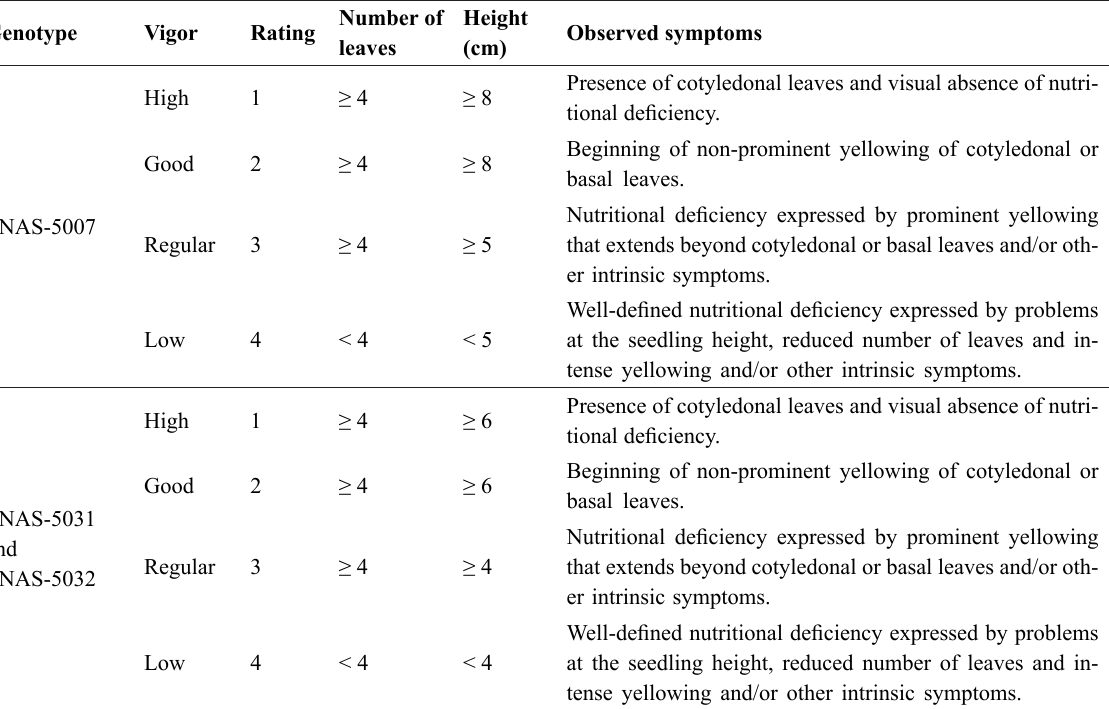
Table 1 Rating scale proposed to assess the seedling vigor (SV) of the three pepper genotypes developed on organic substrates